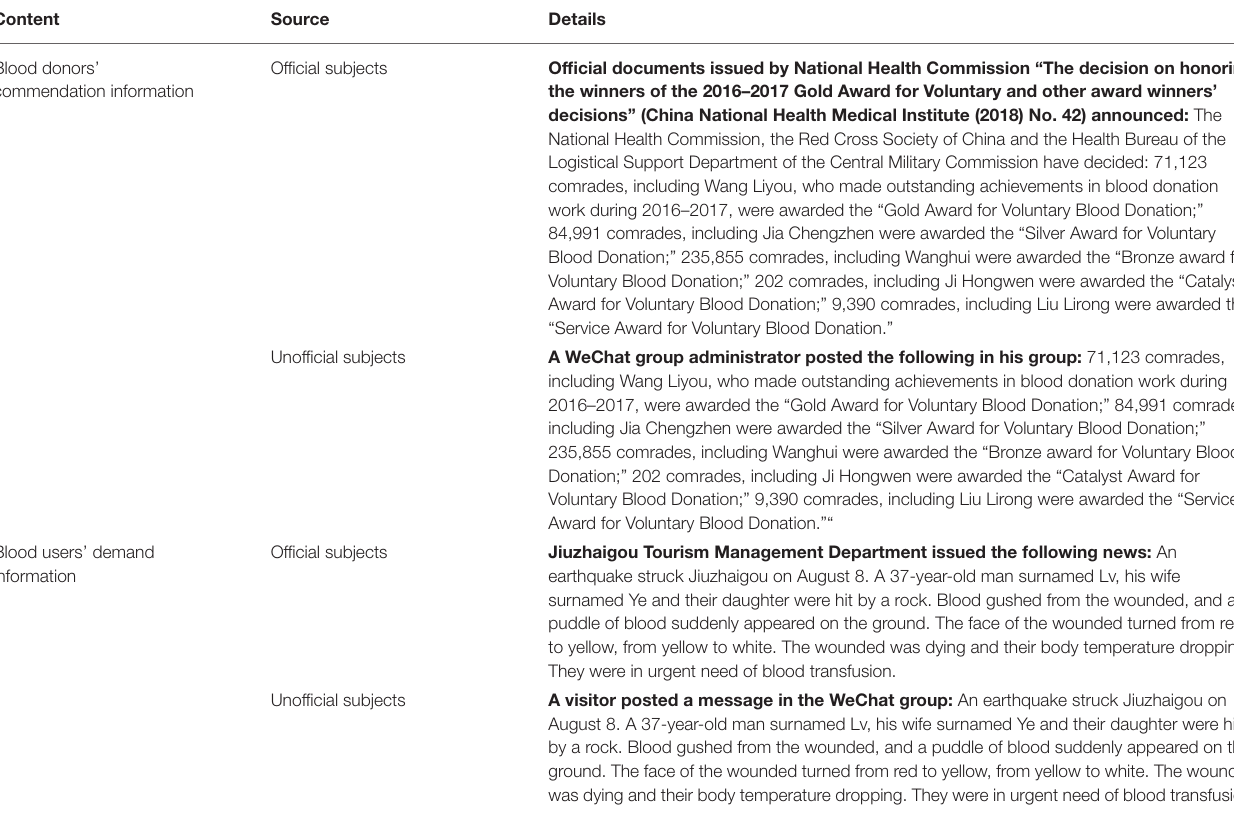
TABLE 1 | The detailed experimental